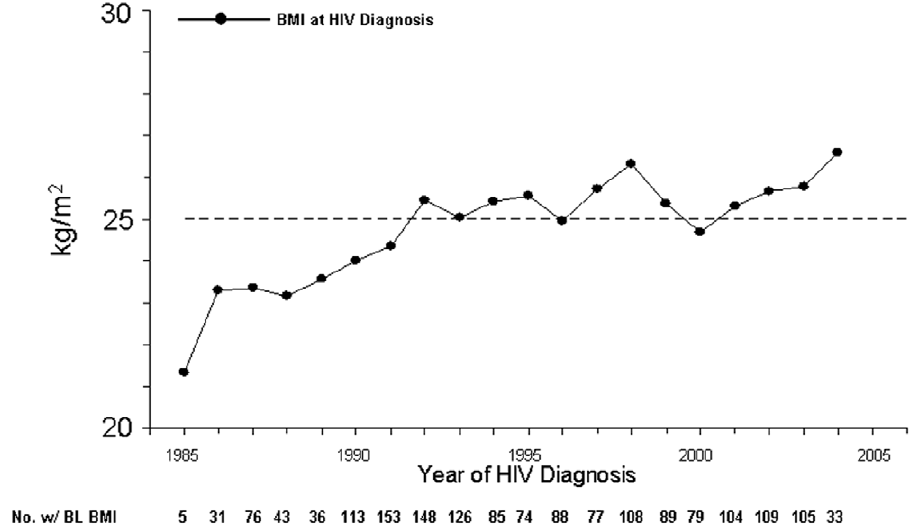
Figure 2. Trends in Mean BMI Measurements at HIV Diagnosis during the HIV Epidemic.